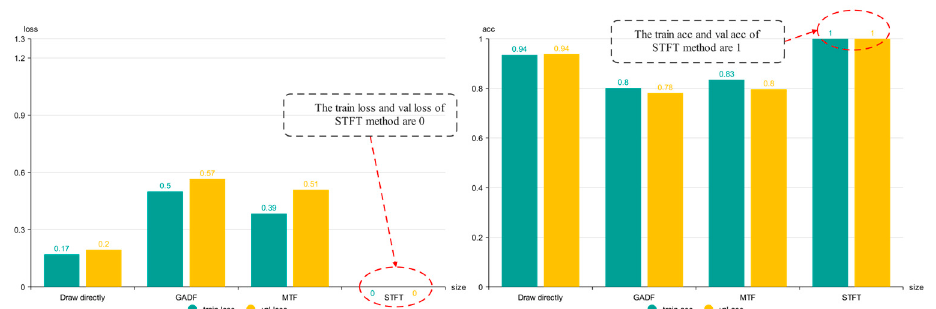
Figure 11. Training results of single-channel data in CWRU: ( a ) train loss and val loss; ( b ) train acc and val acc. Table 3. Final loss and accuracy of single-channel dataset in CWRU.